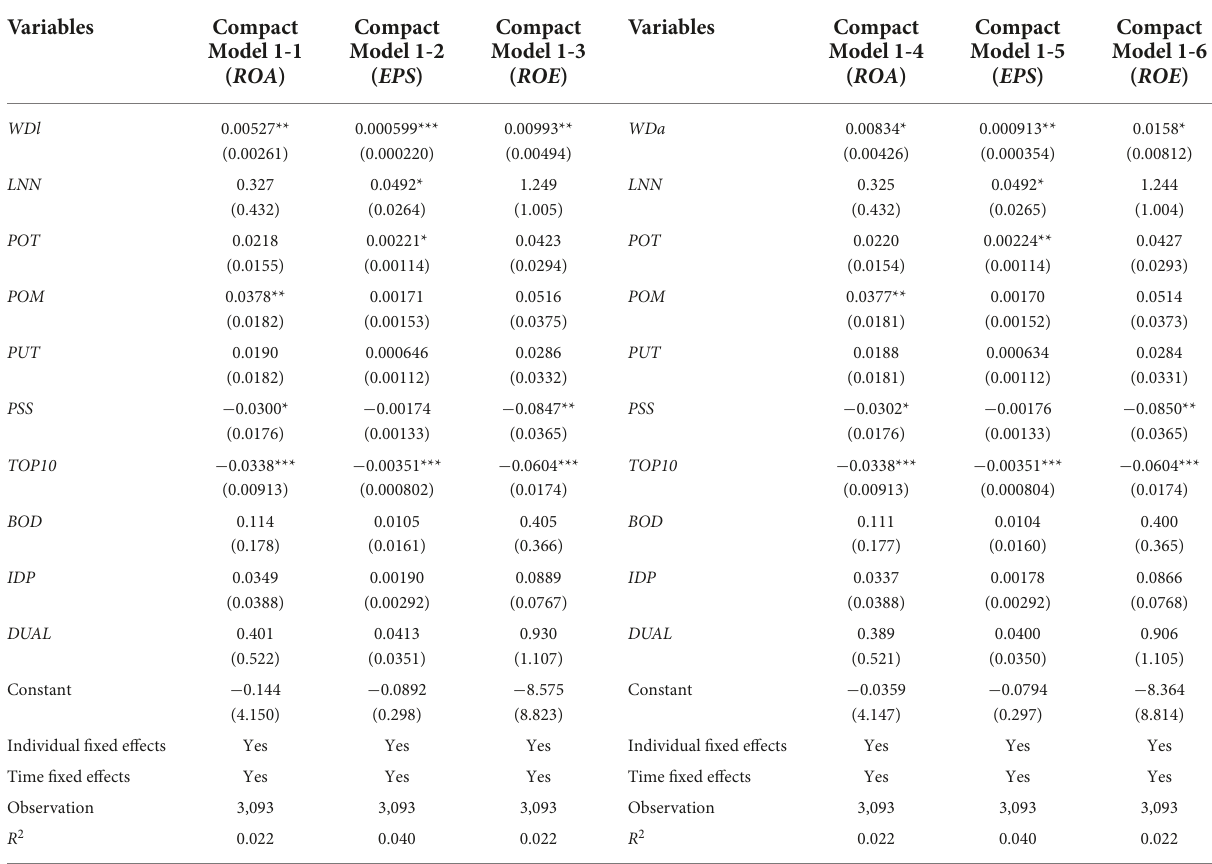
TABLE 6 Compact Model 1 containing only the one-degree term of